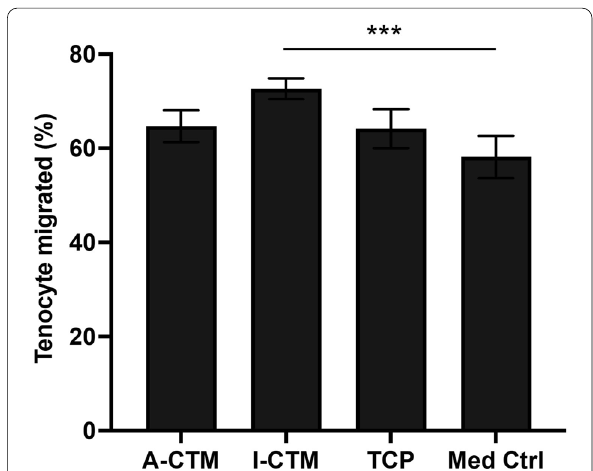
Fig. 4 Effects of conditioned media on tenocyte migration. Conditioned medium was collected from cells cultured on connective tissue matrices for 24 h. The migration of tenocytes in the presence of conditioned media was monitored using the transwell assay. Migration was expressed as the % of migrated cells to the total number of cells. Data shown are mean SD ( n 3). * p 0.05, ± = ≤ ** p 0.01, *** p 0.005. Abbreviations: A-CTM, AmnioFill ® connective ≤ ≤ tissue matrix; B-CTM, BioRenew ™ connective tissue matrix; I-CTM, Interfyl ® connective tissue matrix; Med Ctrl, medium control; TCP, tissue culture